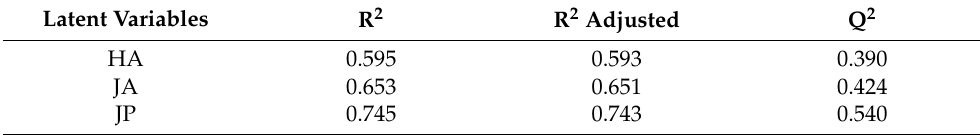
Table 10. Quality criteria (R 2 and Q 2